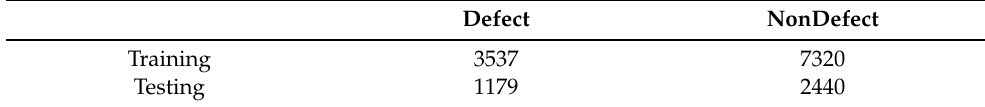
Table 2. The augmented cell image dataset for defect